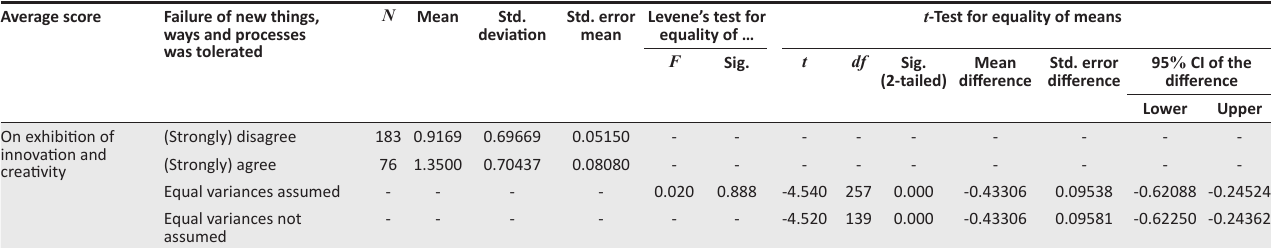
TABLE 3: Tolerance for failure on innovations. Average